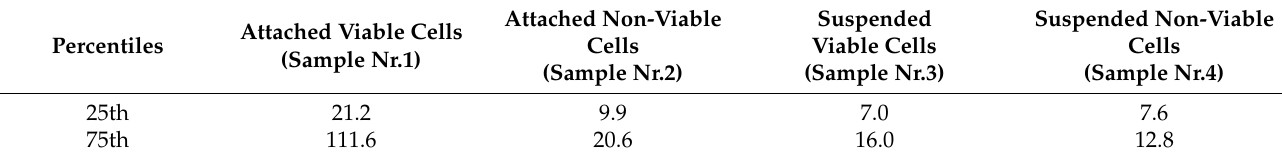
Table 1. Estimation of the variables’ values of the 25th and 75th percentiles of viable and non-viable MCF-7cell samples.